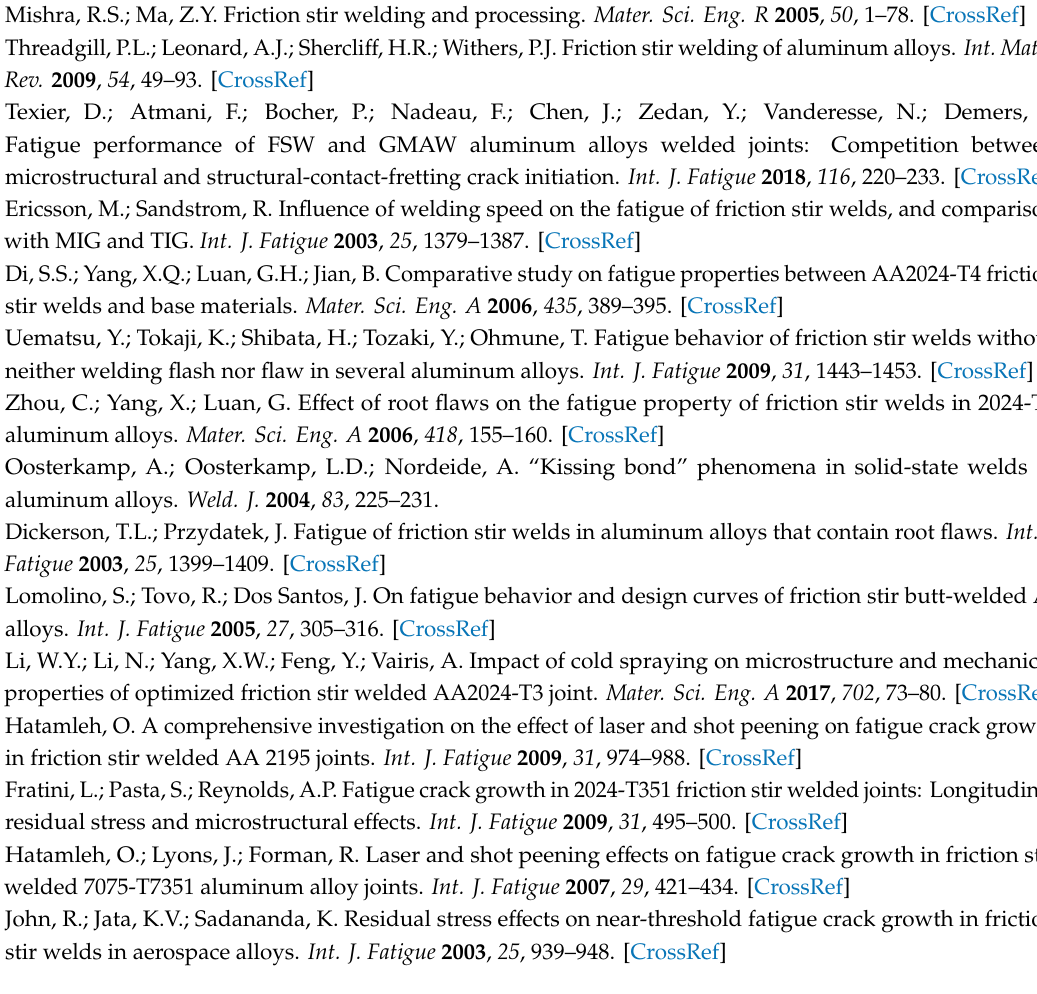
Figure S1: Initial microstructure of the cast Al-Mg-Sc alloy: optical micrograph (a), EBSD grain-boundary map (b) and TEM images (c, d). In (b), low-and high-angle boundaries are depicted as red and black lines, respectively, Figure S2, Initial microstructure of the hot-rolled Al-Mg-Sc alloy: optical micrograph (a), EBSD grain-boundary map (b) and TEM images (c), (d). In (b), low- and high-angle boundaries are depicted as red and black lines, respectively, Figure S3, Initial microstructure of 6061 alloy: (a) EBSD grain-boundary map and (b) TEM image. ED is extrusion direction. In (a), low-and high-angle boundaries are depicted as red and black lines, respectively, Figure S4, Design of the fatigue specimens machined from the welded sheets of Al-Mg-Sc alloy (a) and 6061 alloy (b). In all cases, units are mm. Not in